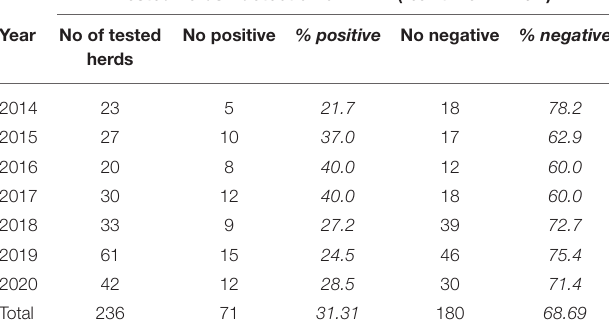
TABLE 4 | Results of tested herds by real-time RT-PCR for the detection of BVDV within voluntary BVDV control programme in Slovenia (2014–2020). Tested herds - detection of BVDV (real-time RT-PCR) Year No of tested